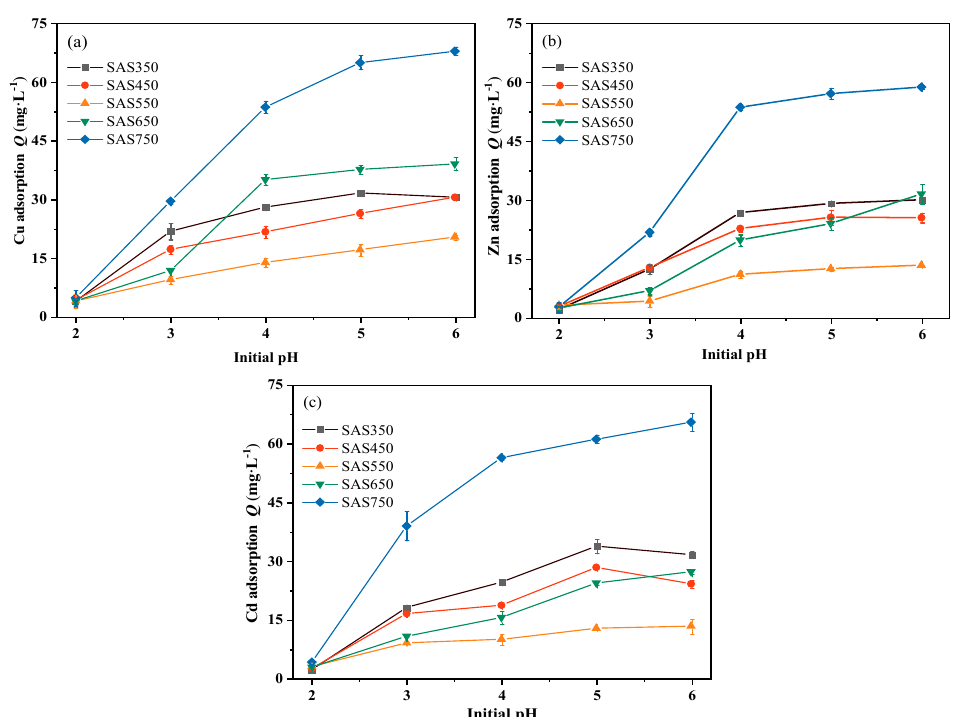
component) content of the biochar increased gradually; however, the amounts of adsorbed Cu(II), Cd(II) and Zn(II) initially decreased and subsequently increased (SAS750 Figure 1. The effects of different solution pH on the sorption capacity of Cu(II) ( a ), Zn(II) ( b ), and Figure 1. The effects of different solution pH on the sorption capacity of Cu(II) ( a ), Zn(II) ( b ), and Cd(II) ( c ), respectively. > SAS350 > SAS550) (Figure 2e). Cd(II) ( c ), respectively.